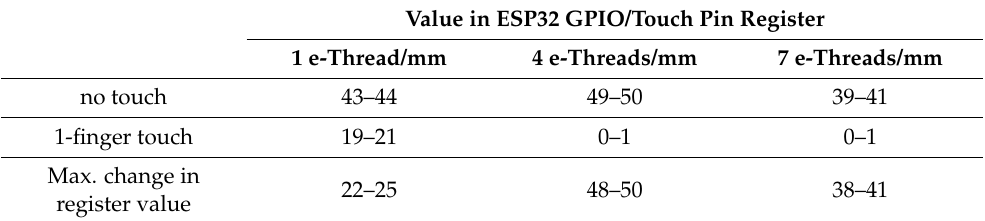
Table 6. Effect of the e-thread density on the performance of embroidered